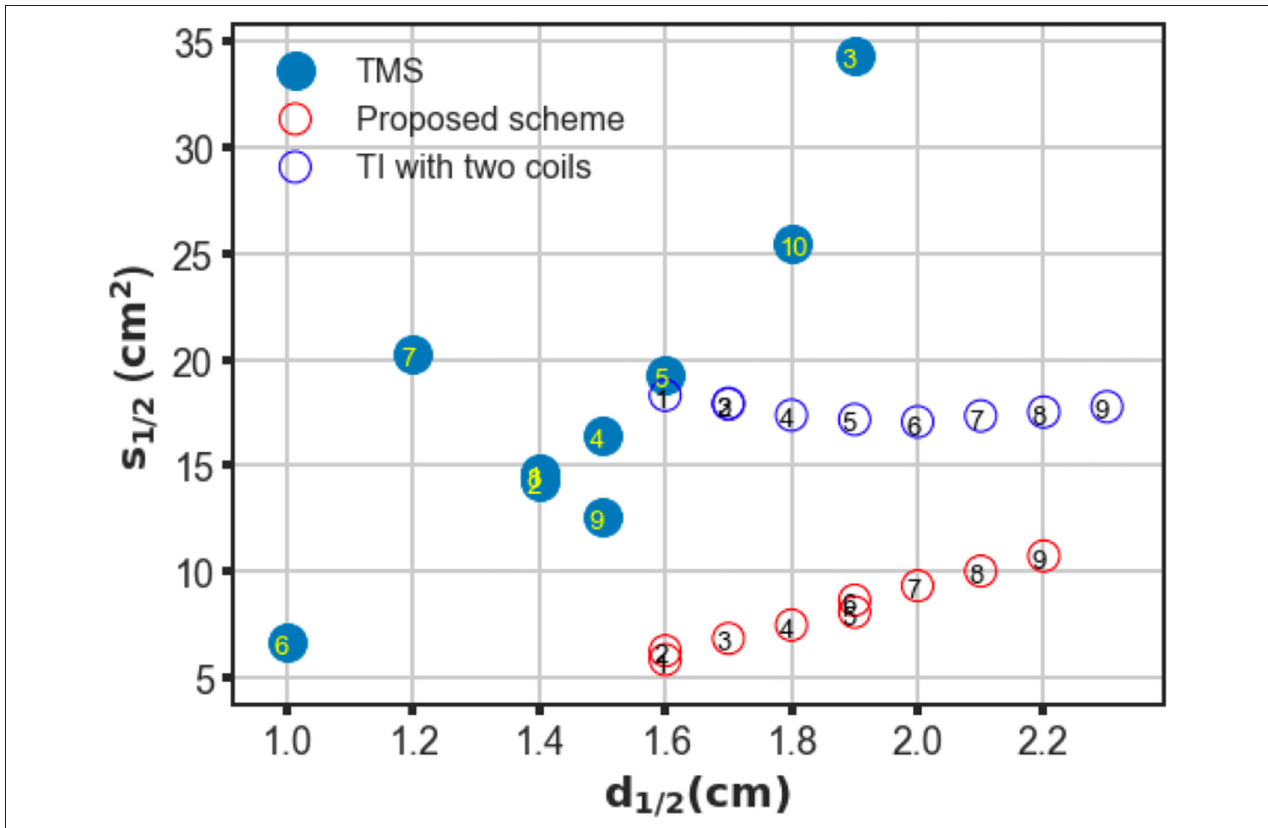
FIGURE 4 | Trade-off between depth (cid:0) d 1 / 2 (cid:1) and focality ( S 1 / 2 ) of conventional TMS systems, two-coil, and four-coil TI stimulations. For TMS systems, different coil configurations are labeled as follows: ‹ Magstim 70 mm figure-8 coil (P/N 9925, 3190), › MagVenture C-B65 butterfly coil, fi Magstim double cone (P/N 9902), fl MagVenture MC-B70 butterfly, (cid:176) Eccentric double cone coil with center-dense windings, – Magstim 25 mm figure-8 (P/N 1165), † Cadwell Corticoil, ‡ Cadwell B-shaped coil, · 50 mm V-coil, and (cid:181) MagVenture D-B80 For the TI magnetic stimulation coils, the edge distance between two opposite coils was changed from 0 to 40 mm at 5 mm intervals (1–9).